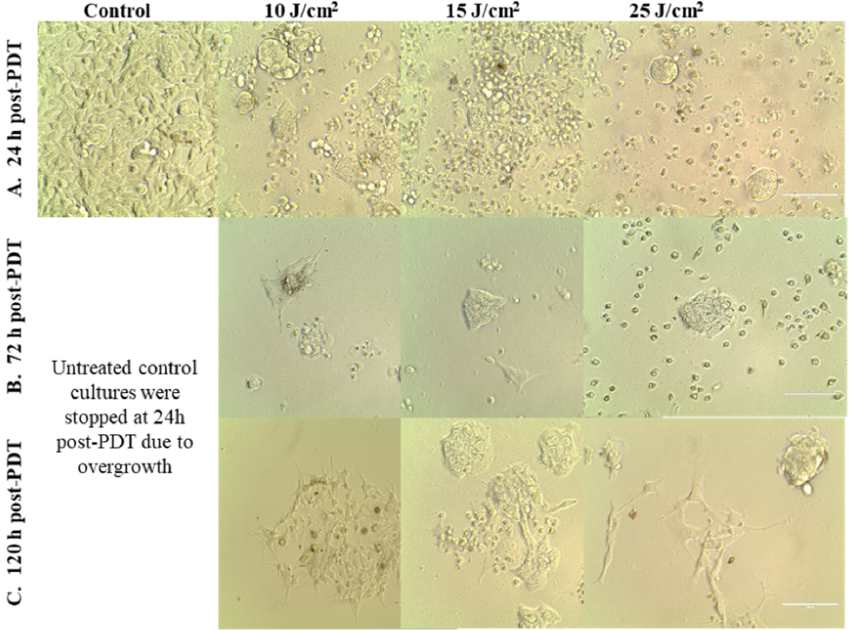
Figure 5. Images of HT29 tumor cells at various time points after PDT performed with various light fluences (10–25 J/cm 2 ), which were delivered with the fluence rate of 50 mW/cm 2 . Cells were visualized by bright-field microscopy at 24 h ( A ), 72 h ( B ) and 120 h ( C ) post-PDT (100 µm scale bar).